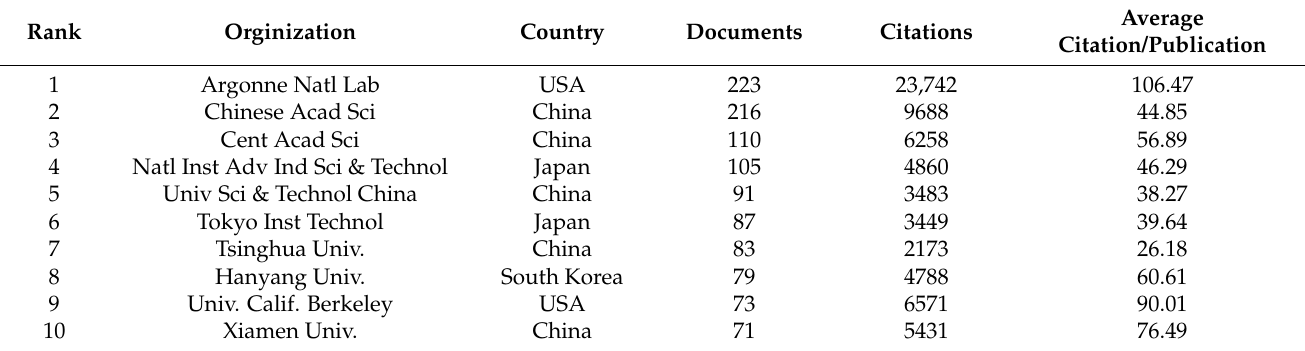
Table 2. Top 10 journals for recycling used lithium-ion